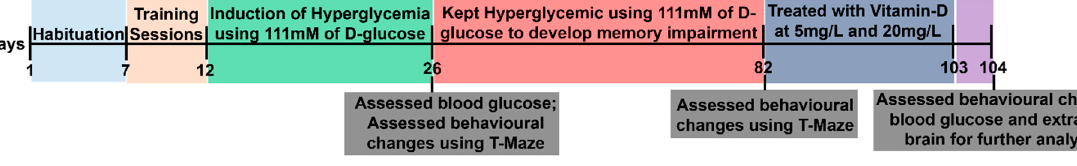
Figure 1. Schematic representation of the experimental protocol used in this